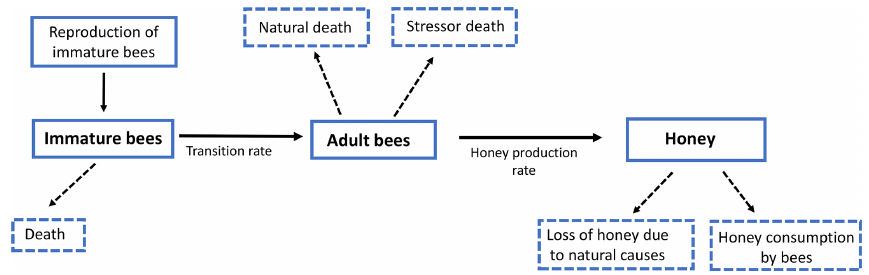
Figure 4. Honey bee and food dynamics represented in the model (Eq. 5). Dashed lines represent food consumption and